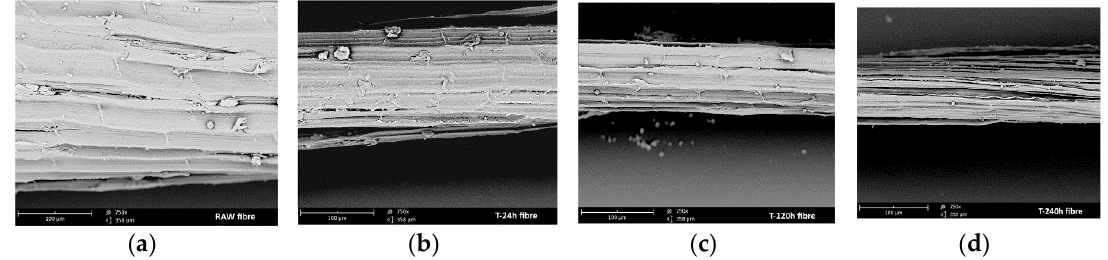
Figure 4. SEM image for sisal fiber with different treatment times: ( a ) Raw, ( b ) 24 h, ( c ) 120 h, and ( d ) 240 h. Reproduced with permission from